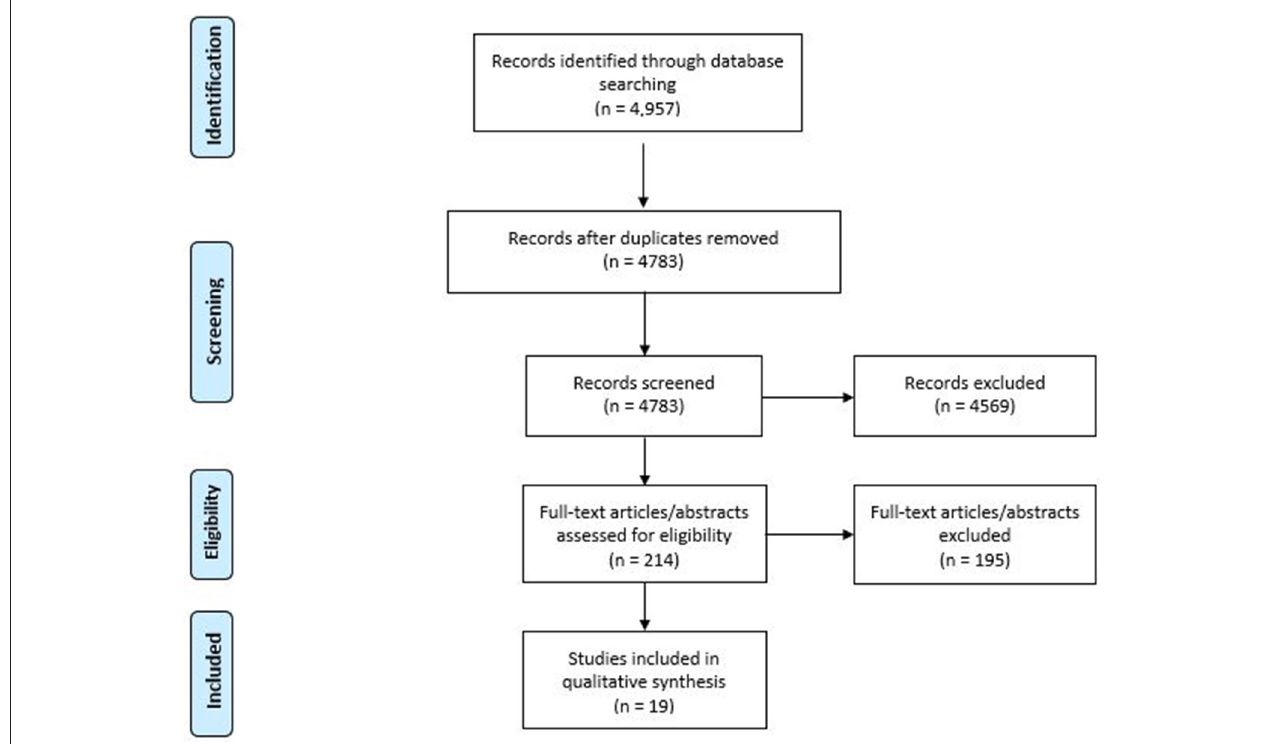
FIGURE 1 | PRISMA flow